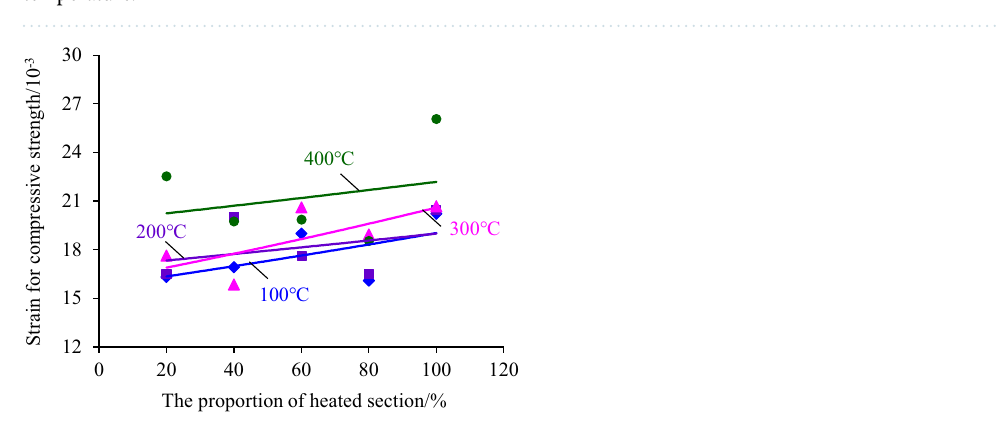
Figure 8. The changing law of the strain corresponding to the compressive strength with the increase of heating temperature.